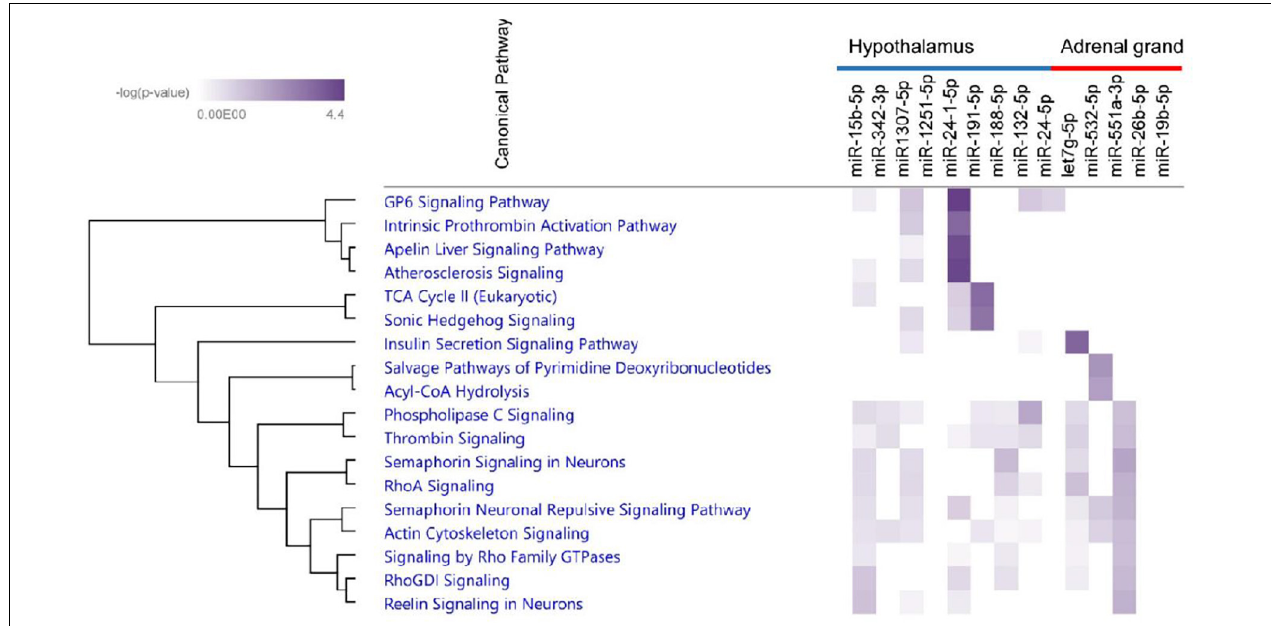
FIGURE 11 | Heatmap showing enriched canonical pathways derived from analyses of miRNAs and corresponding mRNAs. The first nine miRNA including miR-15b-5p, miR-342-3p, miR1307-5p, miR-125-1-5p, miR-24-1-5p, miR-191-5p, miR-188-5p, miR-132-5p, and miR-24-5p belong to bio-signature miRNA of the hypothalamus. The other five miRNA belong to bio-signature miRNA of the adrenal grand. The intensity of color indicates significance from light to